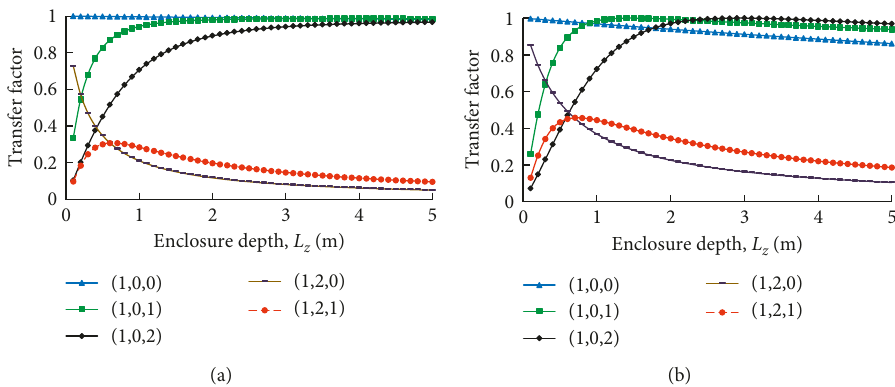
Figure 2: Effect of enclosure depth on the coupling property of the panel-enclosure coupled system with different panel boundary conditions: panel mode (2,1). (a) Simply supported panel mode (2,1). (b) Clamped panel mode (2,1).